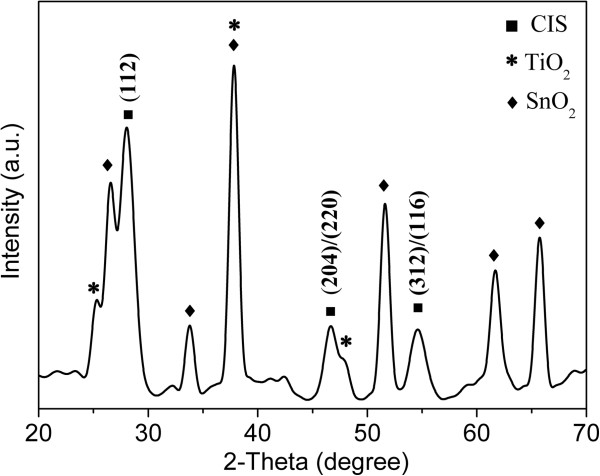
XRD pattern of TiO2/CIS film sample, where CIS film was prepared from 0.1 M InCl3.